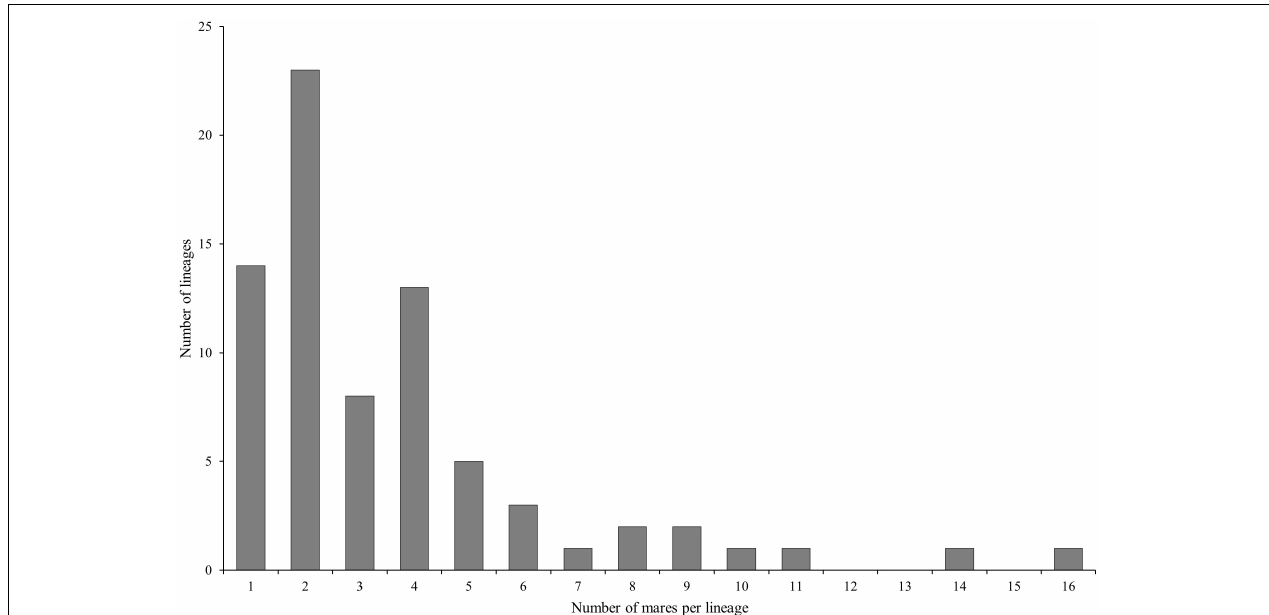
FIGURE 1 | Distribution of the number of mares per lineage in the dataset ( n = 271 Holstein mares belonging to 75 different lineages).